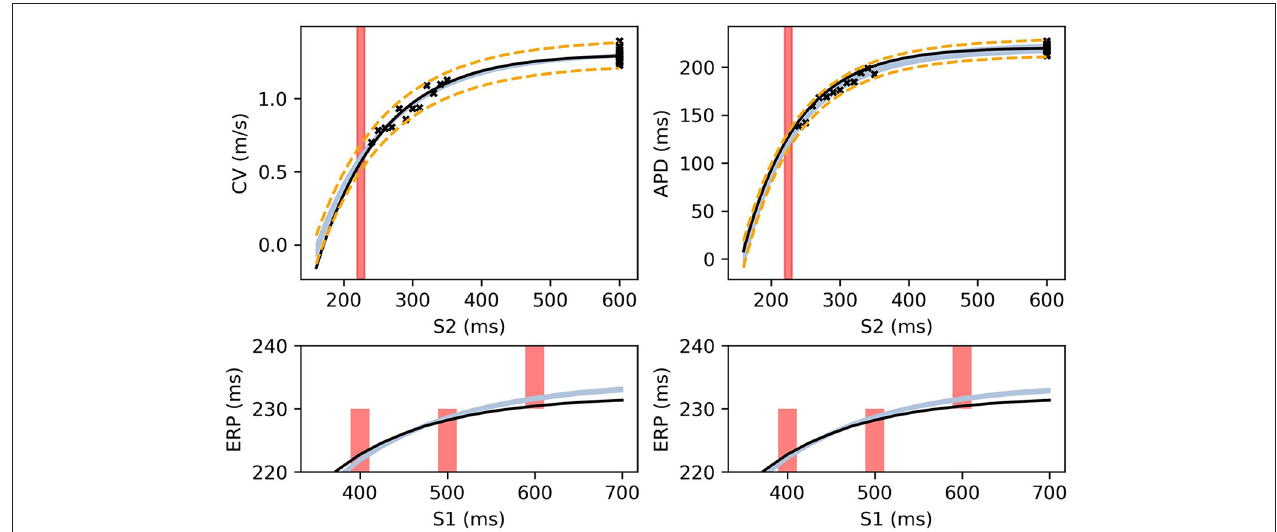
FIGURE 8 | The RCE prediction from maximum a posteriori (MAP) parameter estimates given noisy measurements for (left) CV(S2) and ERP(S1), (right) APD(S2) and ERP(S1), shown as light shaded regions representing RCE 95% confidence intervals. The orange dashed curves show these intervals including the observation error, also learned from MAP fitting. The noisy S2 restitution data are shown as crosses, while the red shaded bars represent observed intervals containing ERP: (top): bars horizontally span ERP(S1:600) interval; (bottom) bars vertically span ERP(S1) interval for several S1. The solid black lines in all plots represent the corresponding ground truth curves.